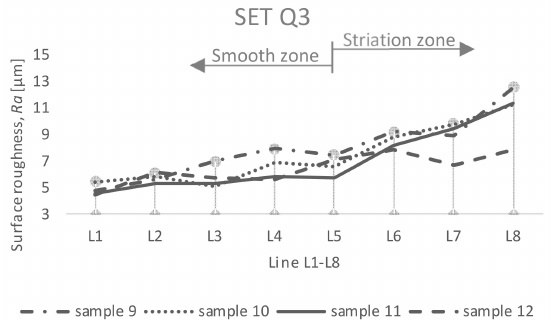
Figure 7. Evaluation of surface topography created by the AWJ (set